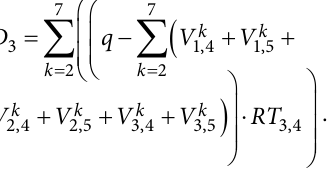
Figure 3. Load profiles on the bi-directional bus route between 7:00…9:00: a – 7:00…8:00 in direction 1; b – 7:00…8:00 in direction 2; c – 8:00…9:00 in direction 1; d – 8:00…9:00 in direction